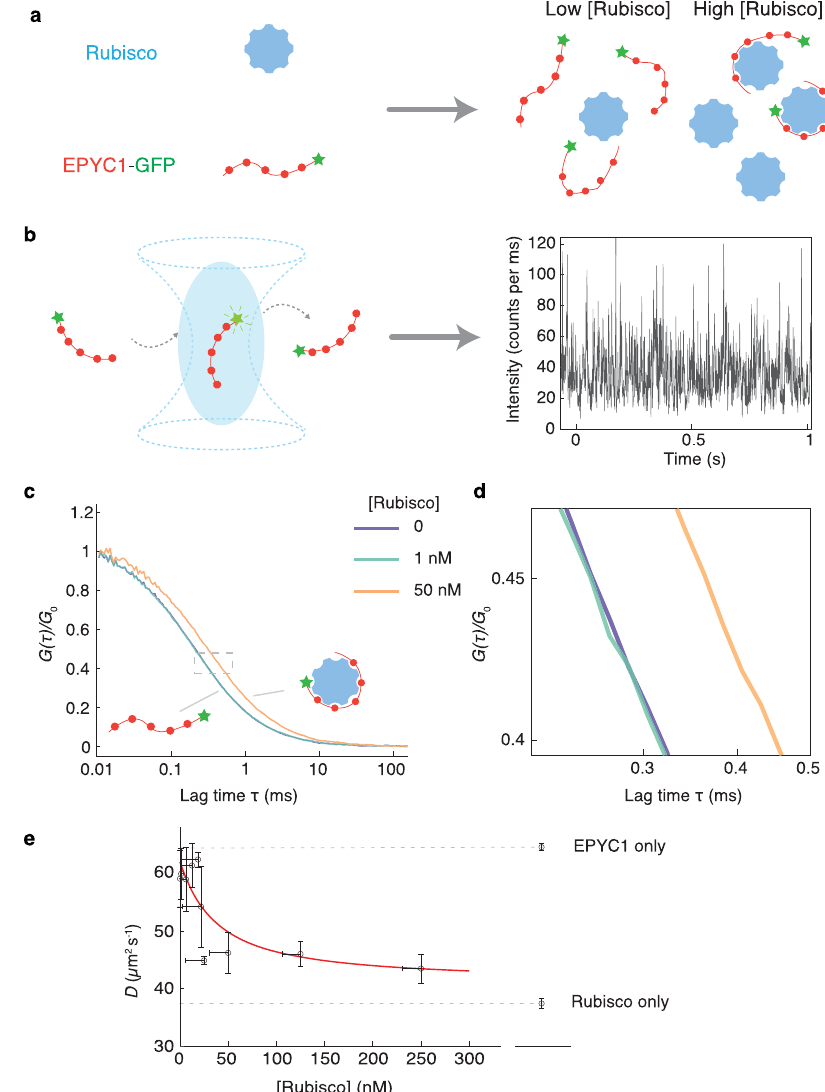
Fig. 2 EPYC1 and Rubisco form complexes when mixed at low concentrations in vitro. a Cartoon illustrating how EPYC1 and Rubisco coexist at different concentrations in the one-phase region. b Schematic depiction of FCS and an example of an EPYC1-GFP fl uorescence intensity time trace ([EPYC1- GFP] = 10 nM). c Fluorescence intensity autocorrelation curves of 10 nM EPYC1-GFP fl uorescence at three different Rubisco concentrations. Each autocorrelation curve is normalized by its fi tted G 0 (e.g., correlation value at τ = 0, Methods). d An enlarged version of the region shown with dashed lines in c . e Diffusion coef fi cient ( D ) of EPYC1-GFP inferred from FCS as a function of Rubisco concentration. Vertical error bars are standard deviations of repeated experiments ( n = 3). The horizontal error bars indicate the estimated uncertainty of the Rubisco concentration in the solution due to protein loss in the measurement chamber (Supplementary Note. 1). The red curve is a fi t to a quadratic model (Supplementary Note. 2) with a K d of ~30 nM. The diffusion rates for EPYC1-GFP-only and for Rubisco-Atto488-only are shown on the right. Concentrations are expressed in terms of Rubisco holoenzymes and EPYC1